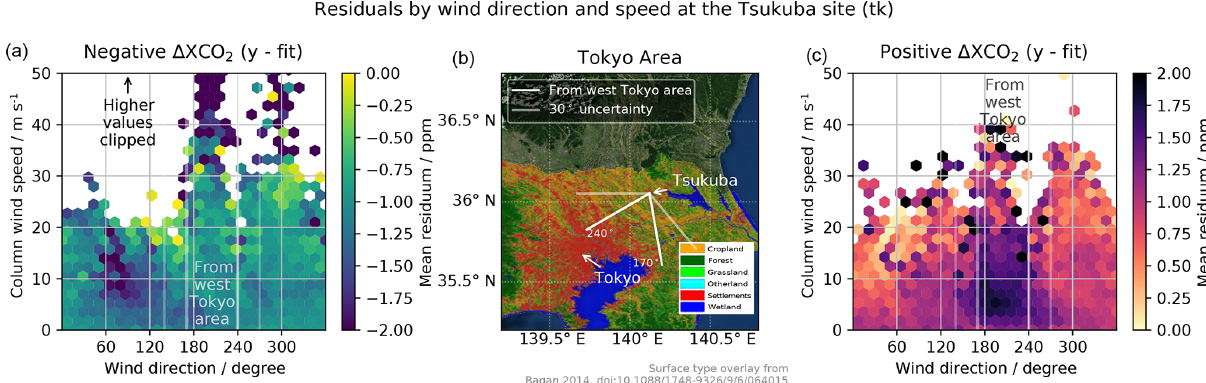
Figure 3. Panel (b) shows a map of Tokyo and its surroundings, retrieved from an ArcGIS REST service (retrieved as EPSG:4301 using a ESRI_Imagery_World_2D request to http://server.arcgisonline.com/ArcGIS, last access: 12 February 2020, via the basemap li- brary in Matplotlib (Hunter, 2007) as described at http://basemaptutorial.readthedocs.io/en/latest/backgrounds.html#arcgisimage, last ac- cess: 17 May 2020. Used with permission (permission for publication of this graph under Creative Commons attribution license granted by Esri). © Authors for panels (a) and (c) . Panel (b) is used by permission. © Esri, ArcGIS. (b) uses surface type overlays by Bagan 2014 (https://doi.org/10.1088/1748-9326/9/6/064015). All panels distributed under the Creative Commons Attribution 4.0 License.) with an over- lay indicating the surface type. The colours in the overlay visualize land use and settlement density (taken from Bagan and Yamagata, 2014). It clearly shows decreasing population density with distance from Tokyo city, along with the long tail of Tokyo settlements towards the north-west. Close by Tokyo Bay in the lower centre of the map, at the south-east perimeter of Tokyo and on the opposite shore, there are multiple coal and gas power plants. The Tokyo city centre and the position of the TCCON site in Tsukuba are marked along with white lines which define an opening angle for incoming wind at Tsukuba which is interpreted as coming from the Tokyo area, along with additional widening by 30 ◦ as an estimate of the actual origin of transported CO 2 arriving at Tsukuba from the given wind direction. These white lines denoting the incoming wind angle limits are reproduced in (c) and (a) as delimiting directions in which the wind blows from the west Tokyo area. Panel (c) shows the positive half of the residuals from Fig. 2, binned by wind direction and strength. The colour represents the mean value of the positive residuals within the bin. Panel (a) shows the negative half of the residuals from Fig. 2, binned by wind direction and strength. The colour represents the mean value of the negative residuals within the bin. The black arrow at the upper edge of (a) indicates that values for wind speeds above 50ms − 1 have been left out to focus on the area between 5 and 15ms − 1 used in the later evaluation. Displaying residuals which are lower than zero in a different graph than residuals which are higher than zero aids visual detection of emissions, because it separates the features of CO 2 sinks (lower than zero) from CO 2 sources (higher than zero). The strongly negative values in (a) at a wind direction around 60 ◦ might be due to biospheric drawdown of CO 2 by woodland, but since the focus of this publication is the emissions from Tokyo, those values will not be evaluated further here. The split of the dataset applied here is purely for visualization: in the following calculations and graphs, negative and positive residuals are used